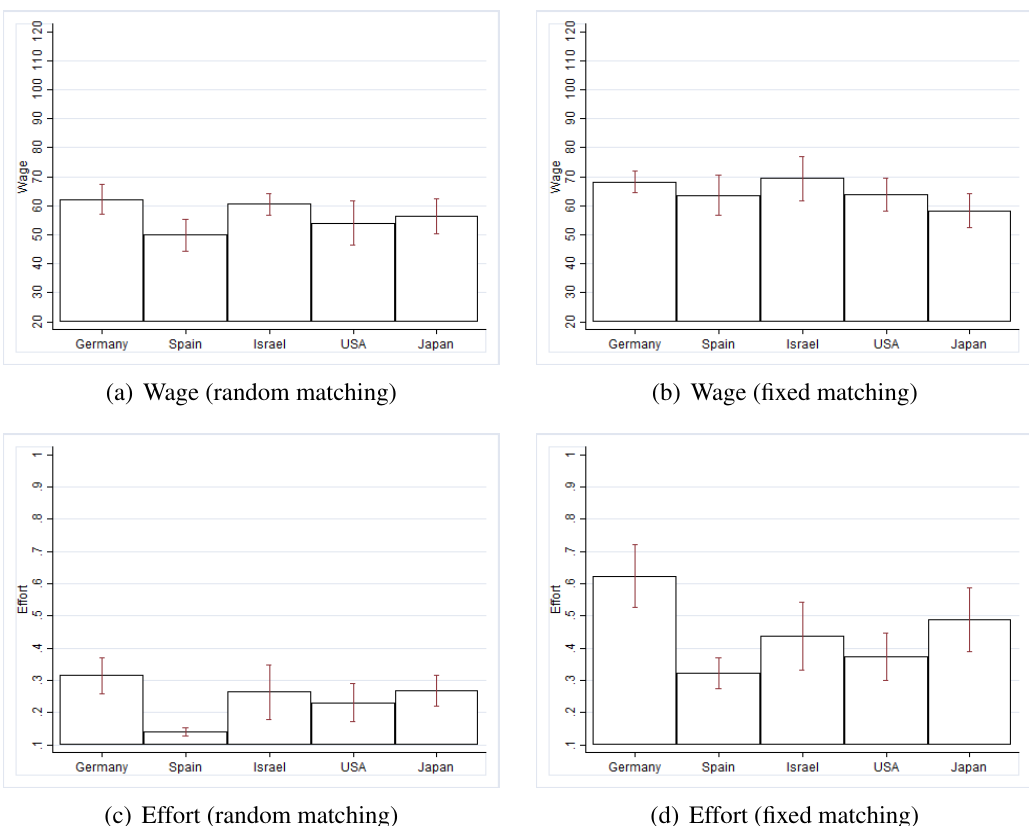
Figure 1. Mean wage and effort levels (with standard errors) for accepted offers in the random- and fixed-matching treatment over Rounds